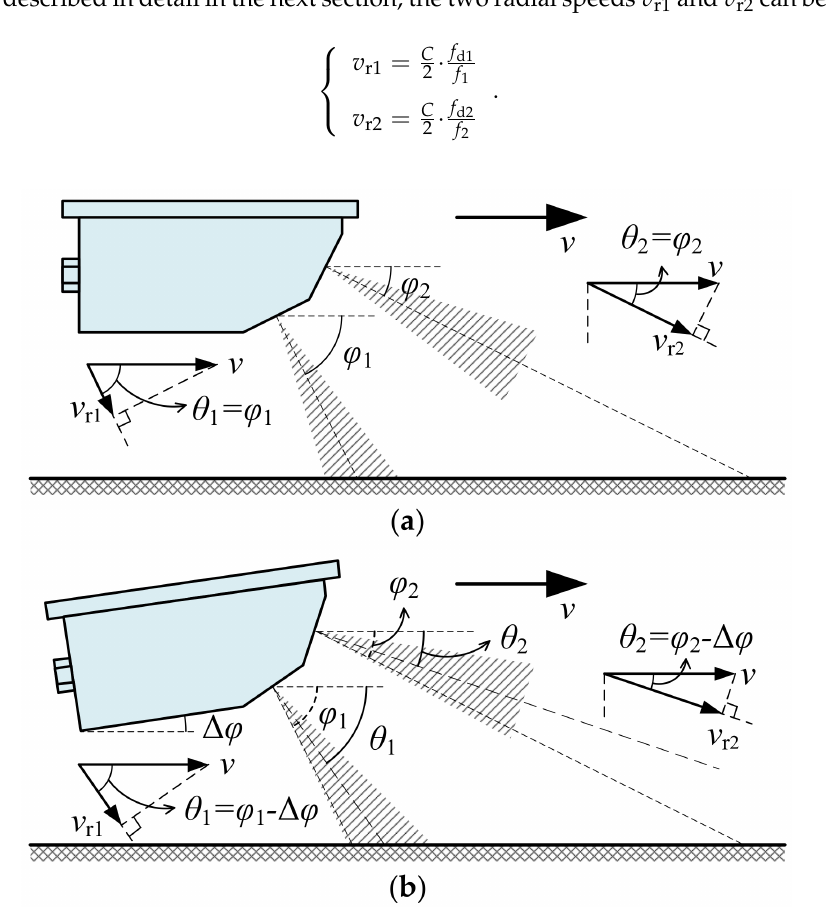
Figure 4. The simplified schematic diagram of the working principle of the DDRS: ( a ) the ideal situation without installation deviation; ( b ) the actual situation with installation